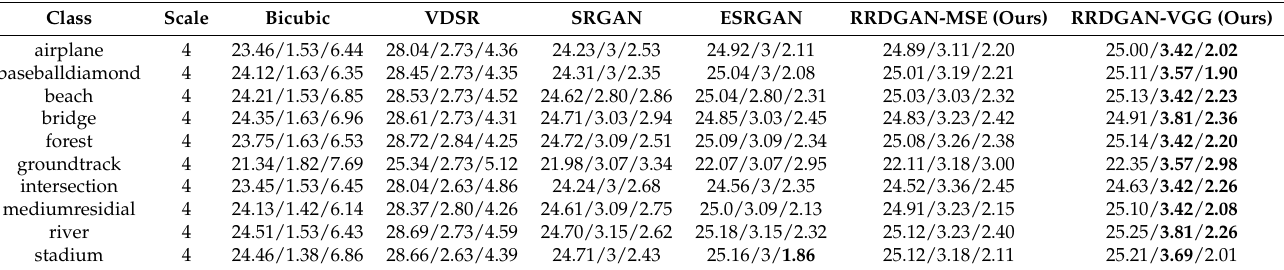
Table 2. MEAN PSNR/MOS/Perceptual Index results (low resolution with white Gaussian noise) of each class in UCMERCED, NWPU-RESISC45 and